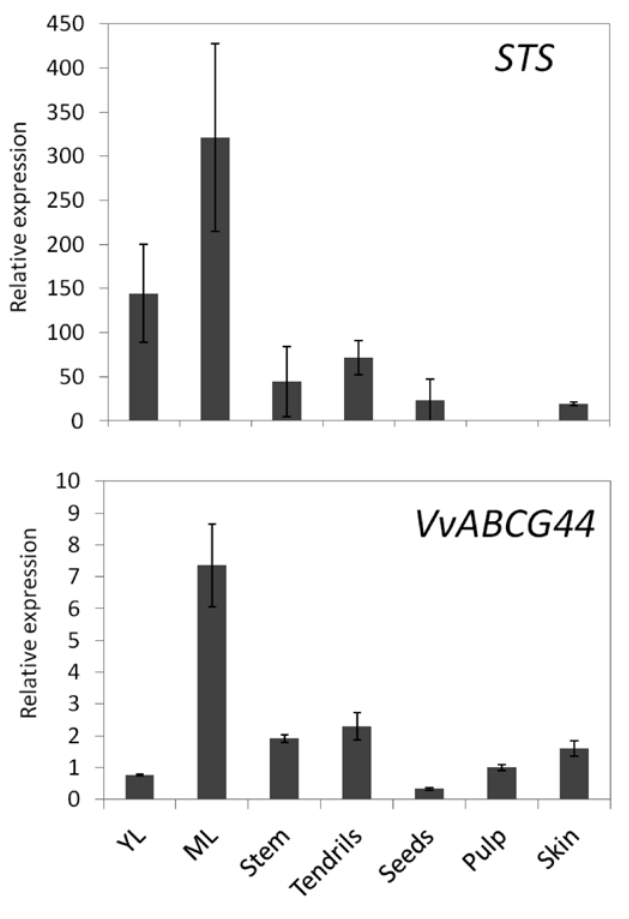
Fig. 3 - Gene expression of STS andVvABCG44 in various grape or- gans [YL ( young leaves), ML; (mature leaves), stem, tendrils, seeds, pulp, and skin]. mRNA levels of STS and VvABCG44 were detected by quantitative PCR. Actin was used as an inter- nal control. Each value represents mean ± SE of three indepen- dent experiments.